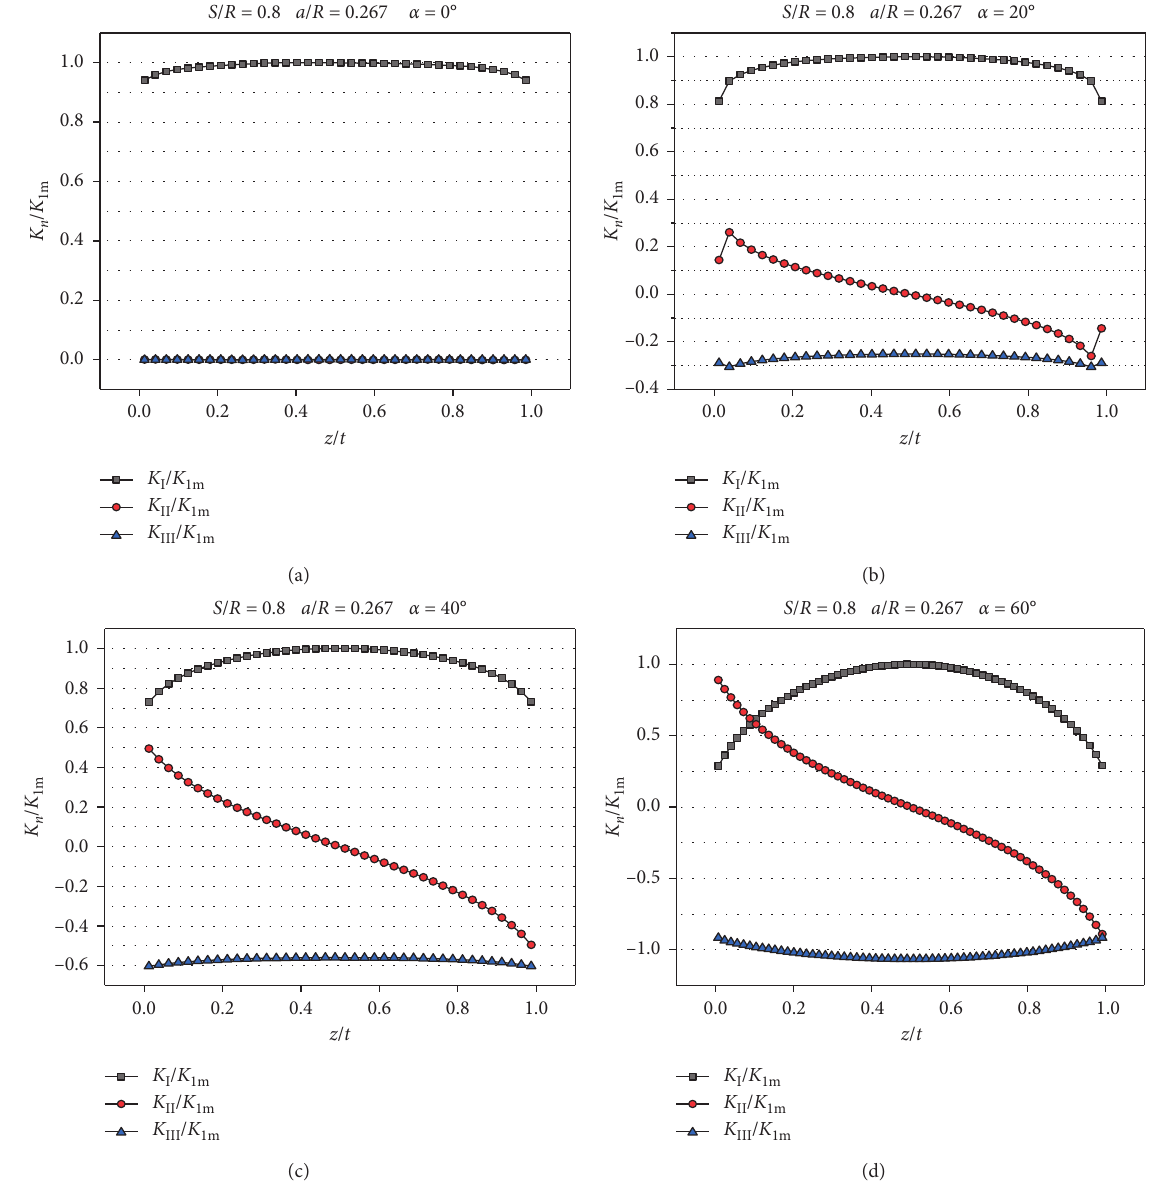
Figure 4: Variations of K n / K Im through crack front of the SCB